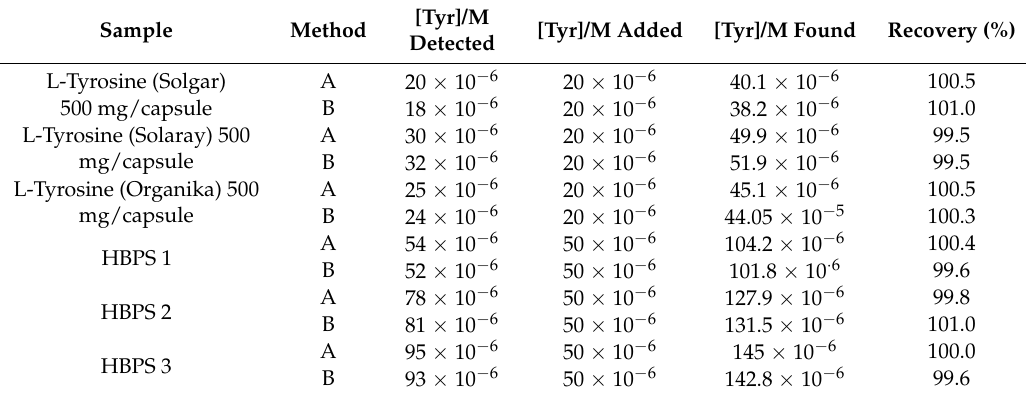
Table 3. Quantitative determination of Tyr from real